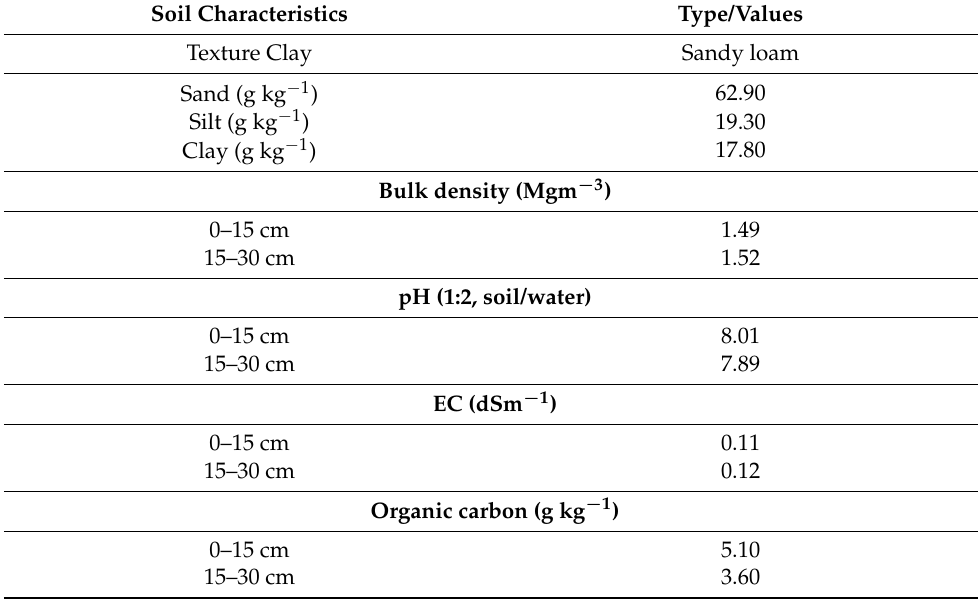
Table 1. Initial soil properties of experimental site